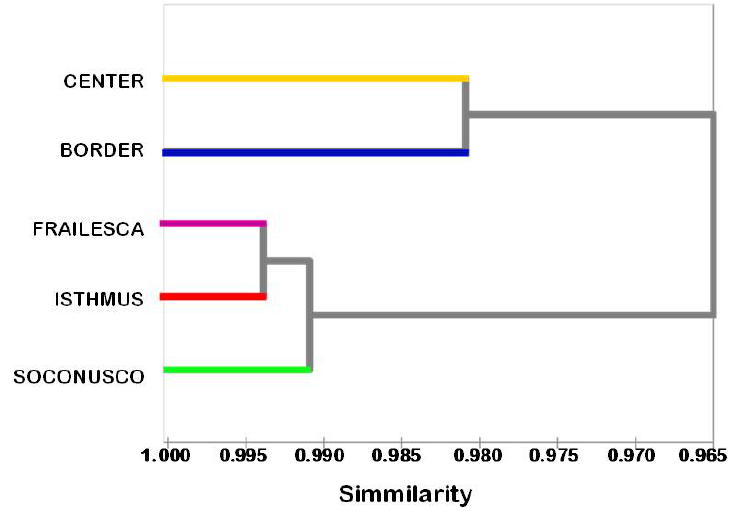
Figure 2. Dendrogram constructed with the coefficient of genetic identity of Nei from amplified fragment length polymorphism (AFLP) data of five populations of Jatropha curcas of Chiapas,